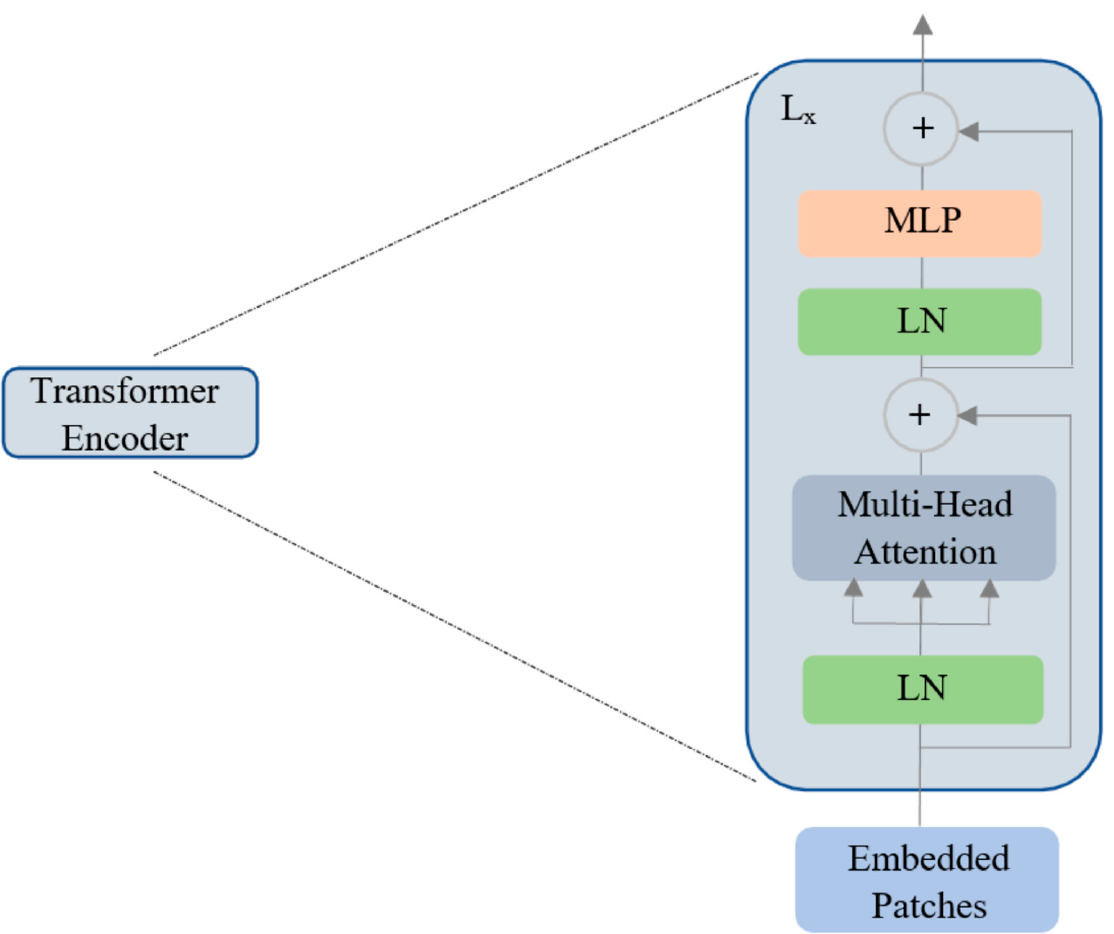
Figure 3. The vision transformer encoder with multi-head self-attention. LN: layer normalization, MLP: multilayer perceptron, L x : transformer encoder ‘ x ’ at layer L.